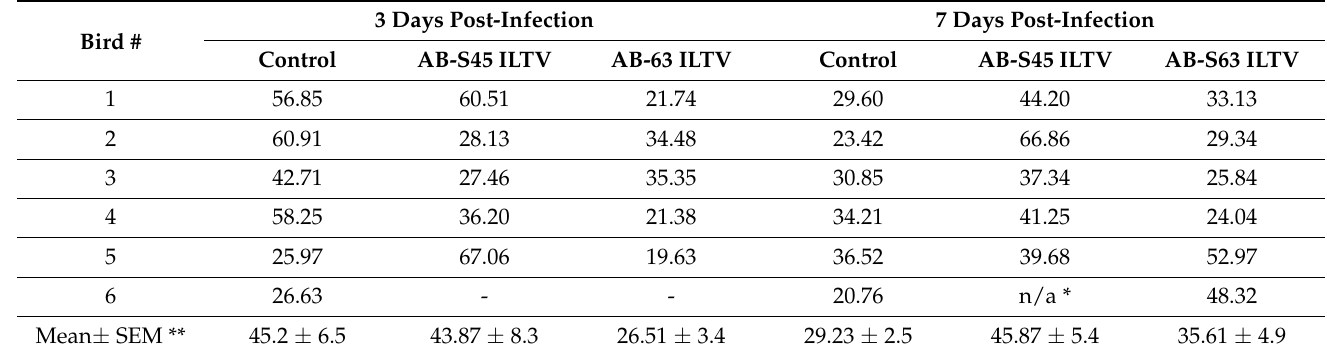
Table 2. The mucosal thickness in the tracheas of chickens at 3 and 7 days after exposure to the AB-S45 and AB-S63 ILTV